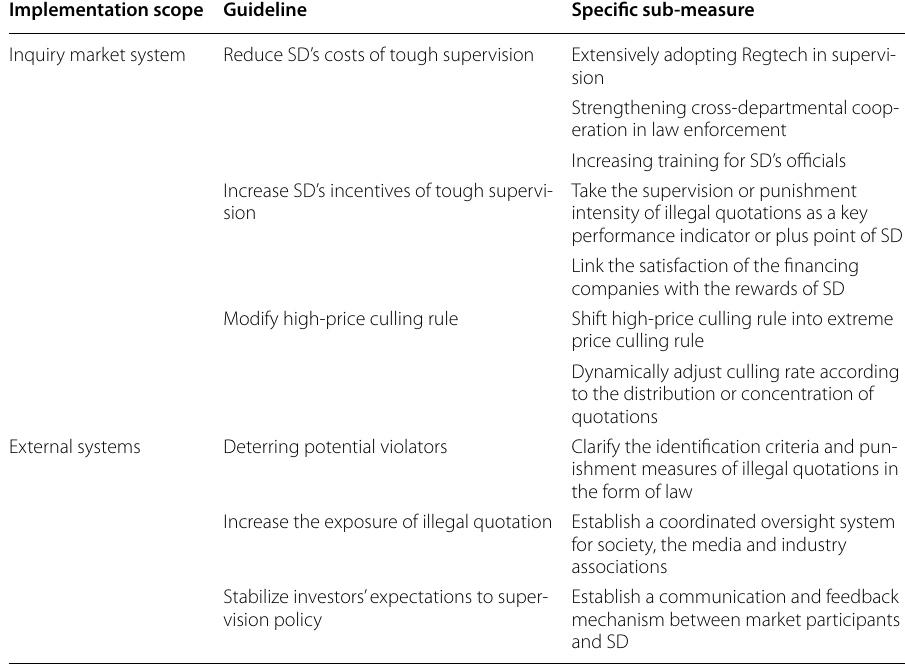
Table 5 Summary of policy recommendations Implementation scope